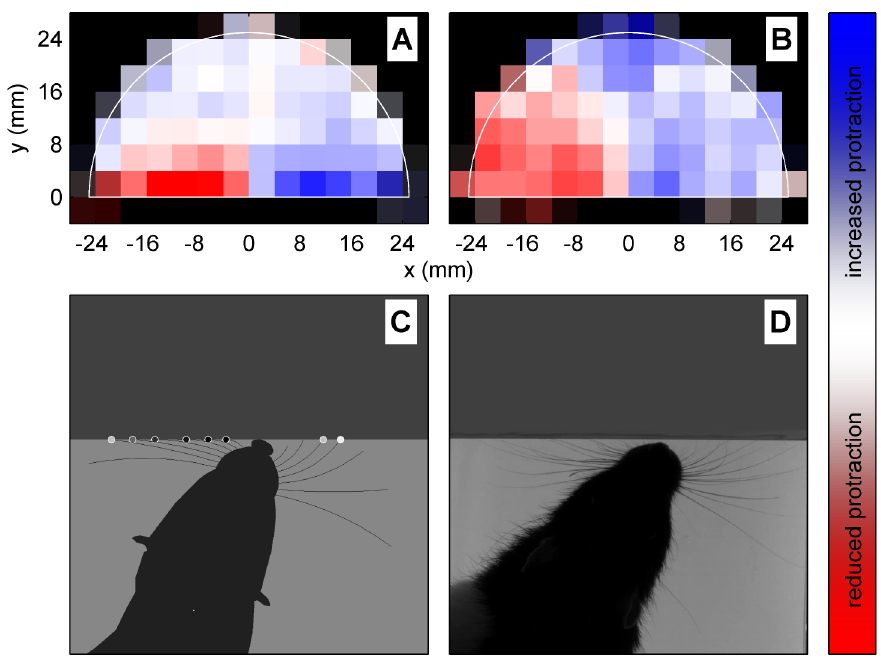
Figure 7. Contact-induced asymmetry. (A) Results from model (see text for analysis method). Mean protraction angle of the whiskers on the left (or right—see text) in NEAR relative to mean value in FAR, plotted against the binned location, ( x , y ) , relative to the fovea of a single nearby wall (4 mm square bins). Red/white/blue indicates mean protraction angle is reduced/equal/increased relative to h (cid:2) , with full saturation for each colour indicating 20 0 difference. White semi-circle indicates 25 mm from fovea at (0,0) , i.e. the region graphed in Figure 4c of Mitchinson et al. (2007) [20]. (B) Results from behavioural experiment (in rat, [20], their Figure 4c), re-analysed on a rectangular grid to match current analysis. Electromyogram strength in NEAR, rather than mean protraction angle, is graphed, relative to mean electromyogram strength in FAR; fully saturated red/blue indicates 33% difference. (C/D) Stills from model (C) and behavioural experiment (D) showing asymmetry in bilateral protraction angles driven by encounter with angled surface. Still in (C) is taken from Video